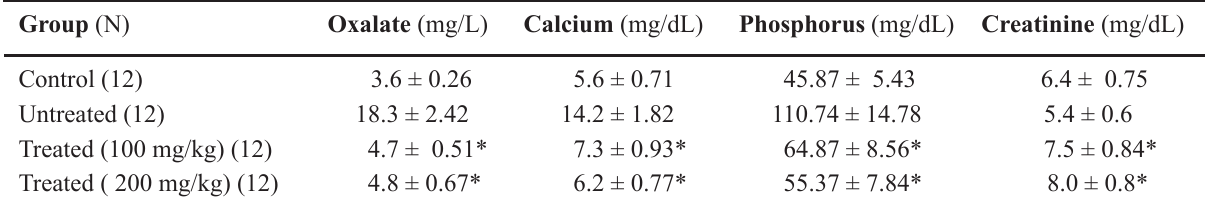
Table 1 – Effect of aqueous extracts of Rubus idaeus on some urinary parameters in control and glyoxylate-treated ani- mals.